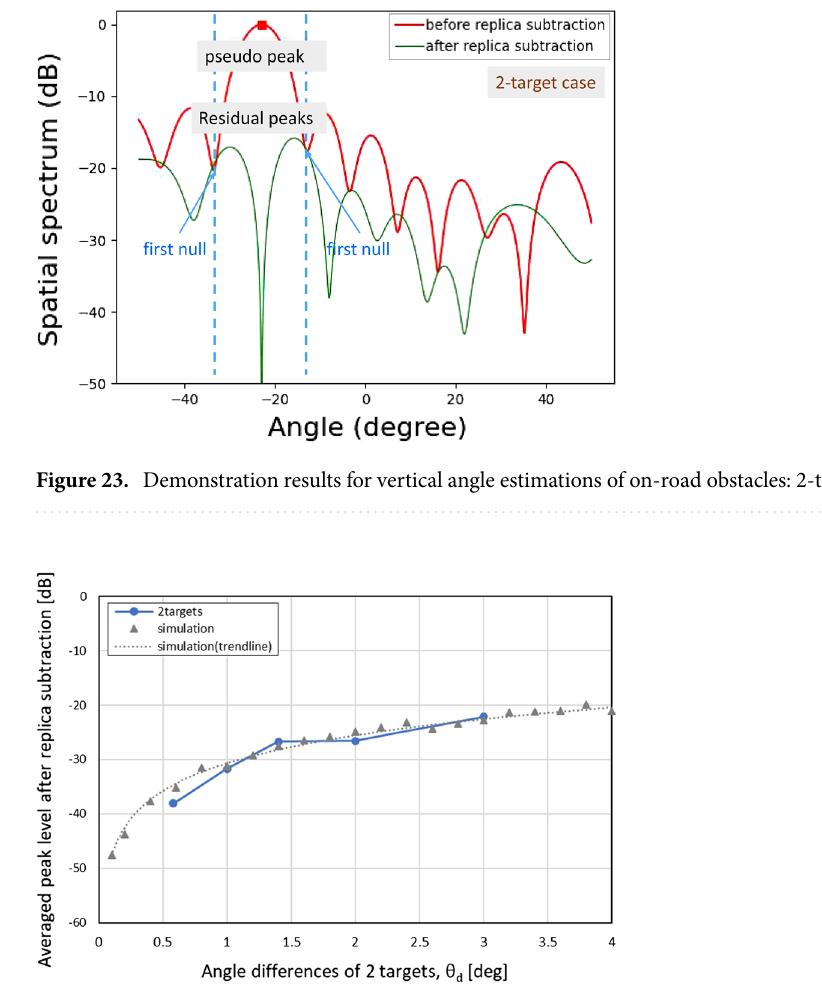
Figure 24. Experimentally obtained relationship between average residual levels and true angle differences. The obtained results are also compared with computationally obtained